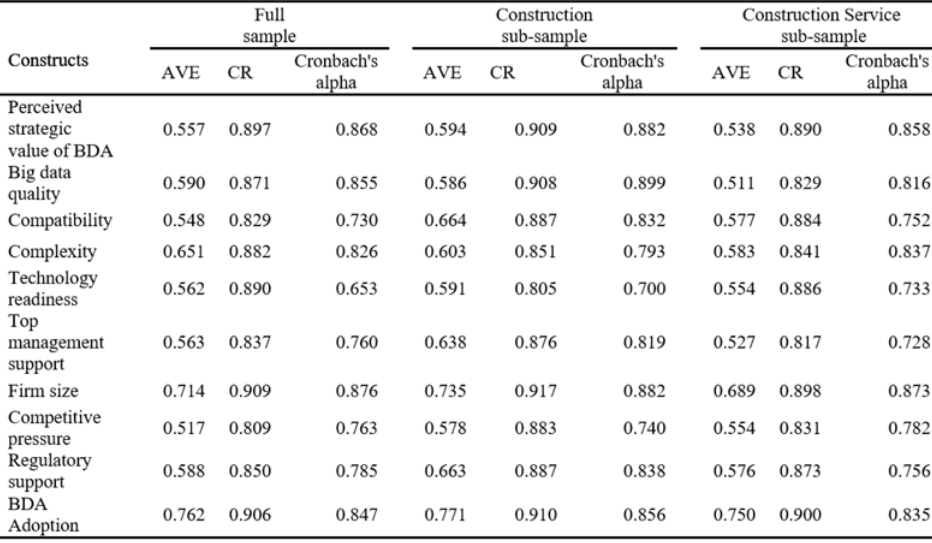
Reliability indicators for sub-samples and full